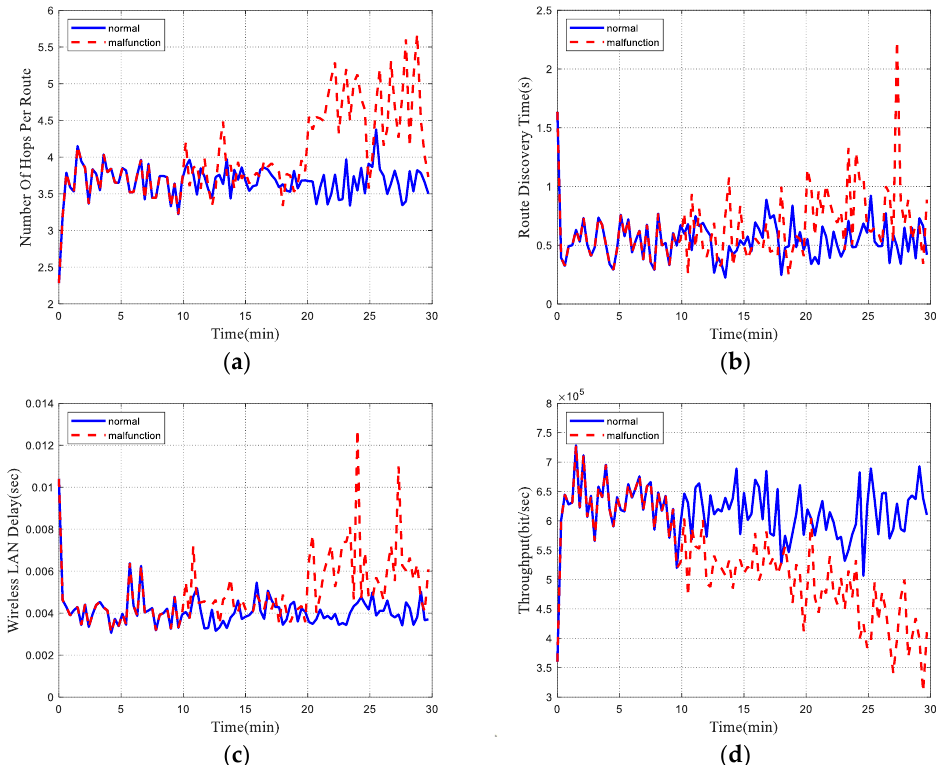
Figure 10. Comparative simulation data before and after node failure in terms of ( a ) number of hops per route, ( b ) route discovery time, ( c ) throughput, ( d ) wireless LAN delay.